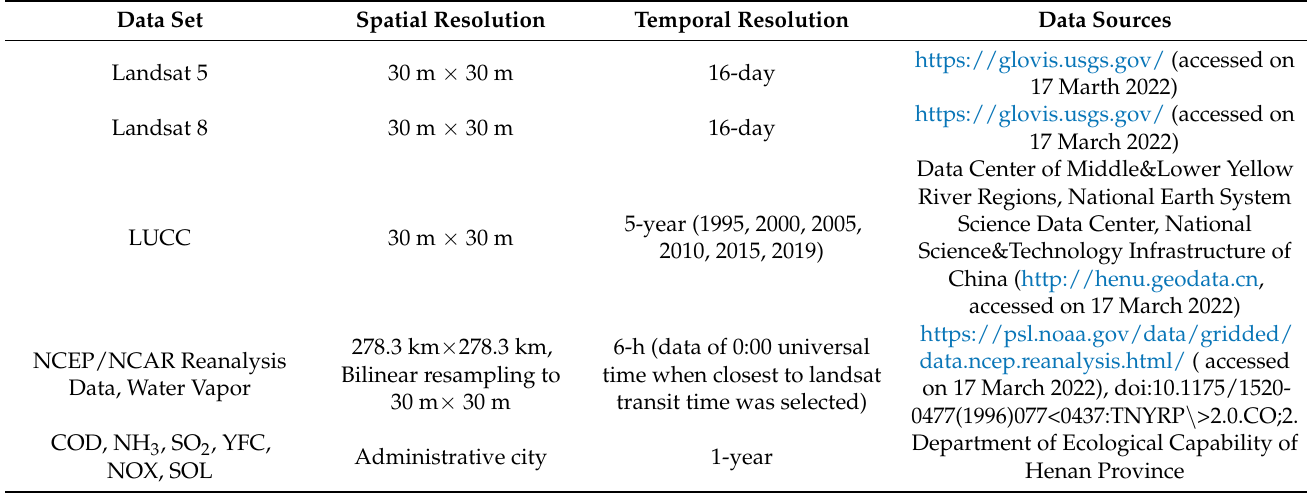
Table 1. Information on the datasets used in this